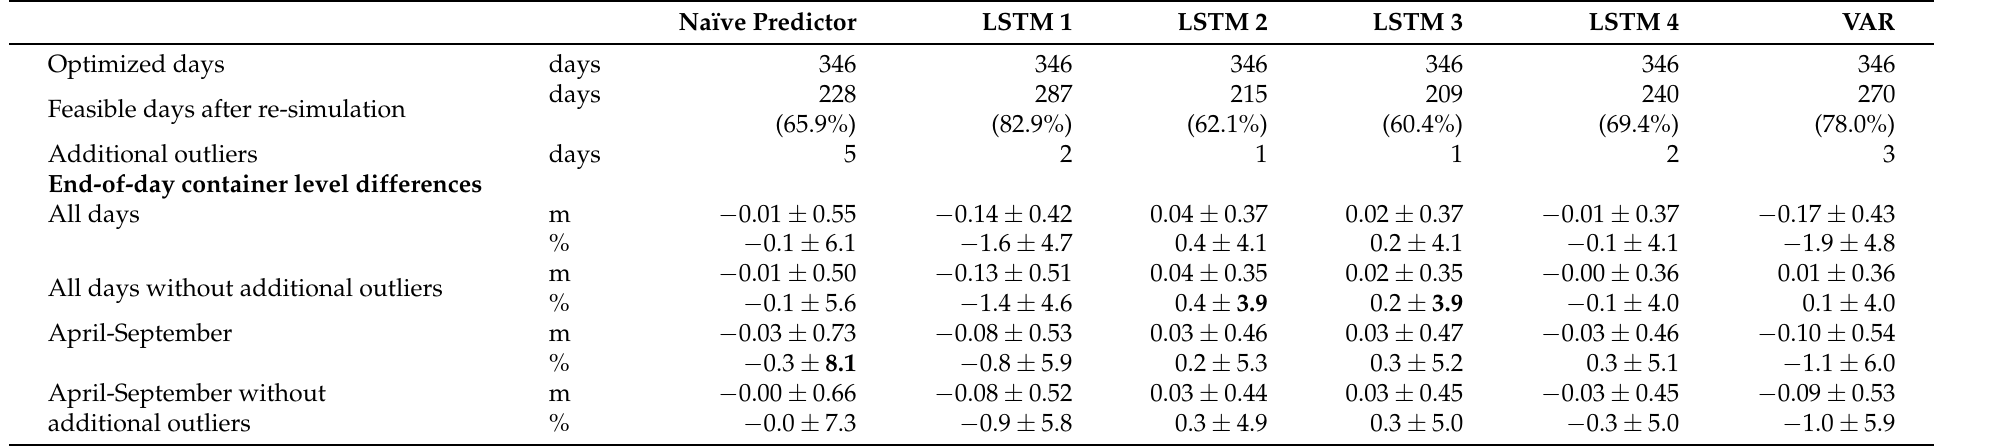
Table 3. Results of optimal pump control. Rows 1–3 show the results concerning feasibility of the simulation and the predictions of the consumption. Rows 4–7 show the mean end-of-day container level differences between the simulations using predicted consumption and realized consumptions for the whole year (row 4–5) and the summer months (rows 6–7) either with or without the outliers from line 3 and Table 2. Each cell in row 4–7 contains four entries: the mean and standard deviation of the absolute container level differences in meters and their representations in percentage of total container height. Bold values: lowest and highest variance in percentage of container level